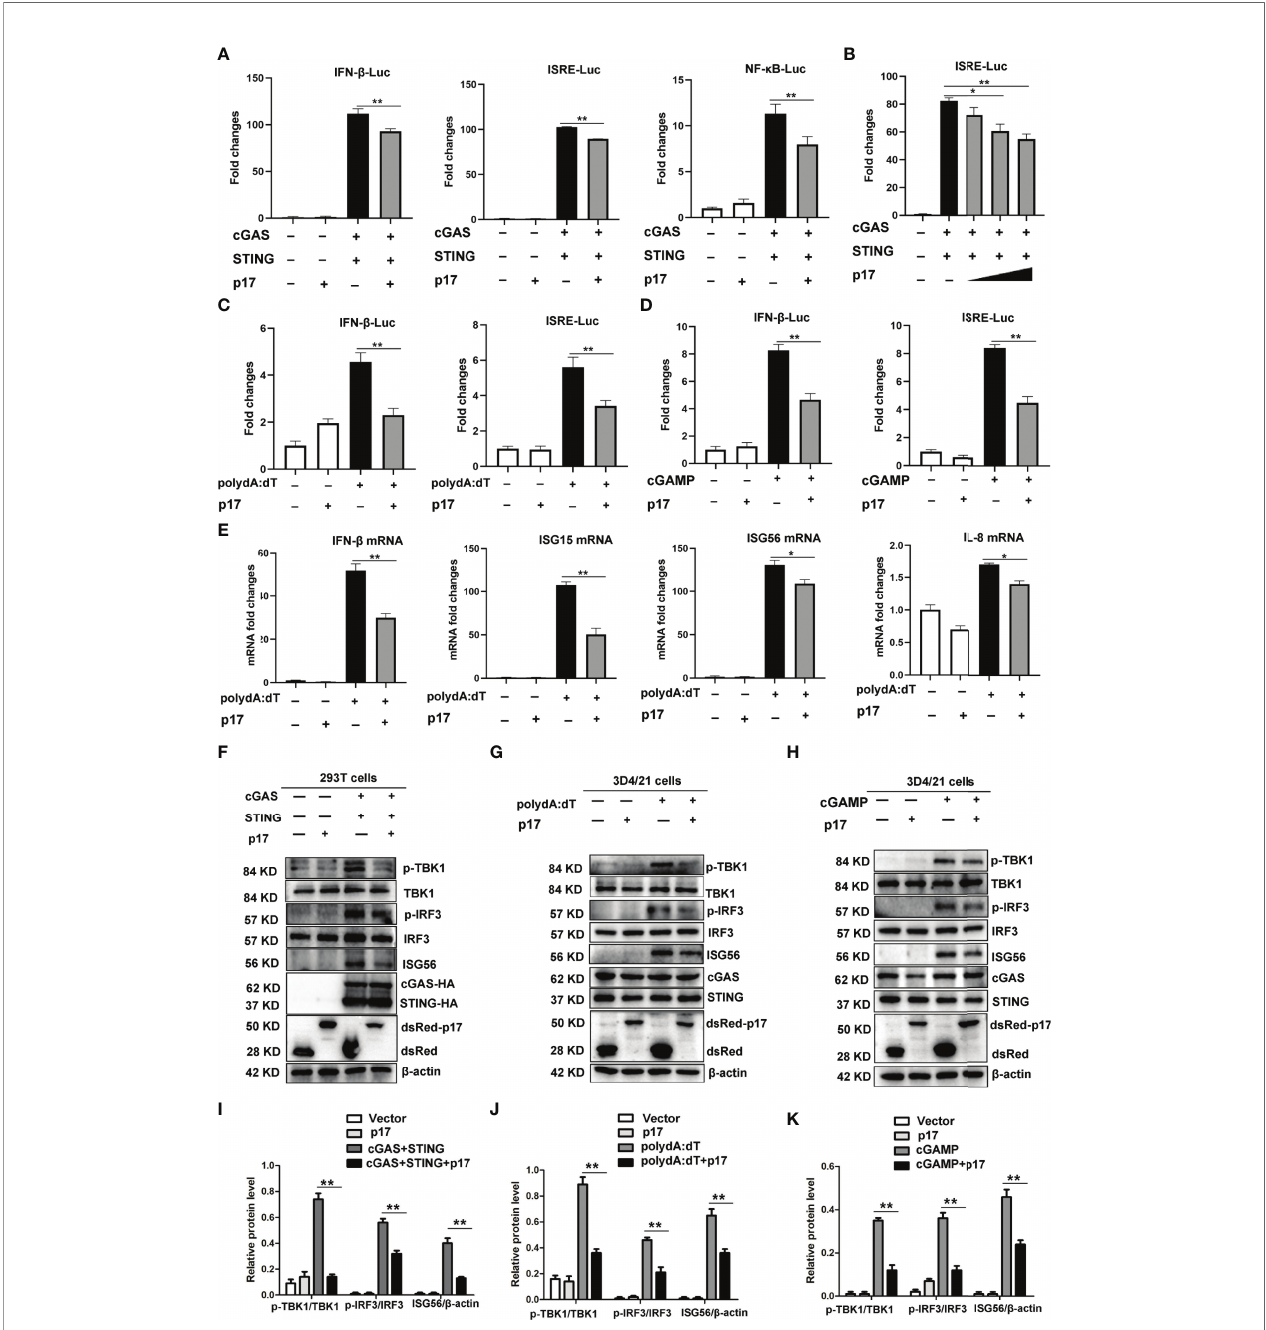
FIGURE 1 | The effects of ASFV p17 on the porcine DNA sensing cGAS-STING pathway. (A, B) 293T cells grown in 96-well plate were transfected with pcGAS (20 ng), pSTING (10 ng), pdsRed-p17 (10 ng) plus IFN Fluc/ISRE Fluc/NF- k B Fluc and Rluc (A) , pcGAS (20 ng), pSTING (10 ng), pdsRed-p17 (5, 10, 20 ng) plus ISRE Fluc and Rluc (B) . (C, D) 3D4/21 cells grown in 96-well plate were transfected with pdsRed-p17 (20 ng), plus IFN- b -Fluc/ISRE-Fluc and Rluc for 12 h, and then stimulated by transfection of polydA:dT (1 m g/mL) (C) or 2 ’ 3 ’ -cGAMP (2 m g/mL) (D) for another 12 h, followed by luciferase measurement. (E) 3D4/21 cells in 12-well plate were transfected with pdsRed-p17 (1 m g) for 12 h and then stimulated by transfection of polydA:dT (1 m g/mL) for another 12 h, followed by RT-qPCR detection of IFN- b , ISG15, ISG56 and IL-8 mRNA. (F, I) 293T cells in 12-well plate were transfected with pdsRed-p17 (0.5 m g), pcGAS (0.5 m g) and pSTING (0.5 m g) for 24 h (G, J) 3D4/21 cells in 12-well plate were transfected with pdsRed-p17 (1 m g), plus polydA:dT (1 m g/mL) for 24 h (H, K) 3D4/21 cells in 12-well plate were transfected with pdsRed-p17 (1 m g), plus 2 ’ 3 ’ -cGAMP (2 m g/mL) for 24 h Relative protein values represent the mean±S.D. * P <0.05, ** P